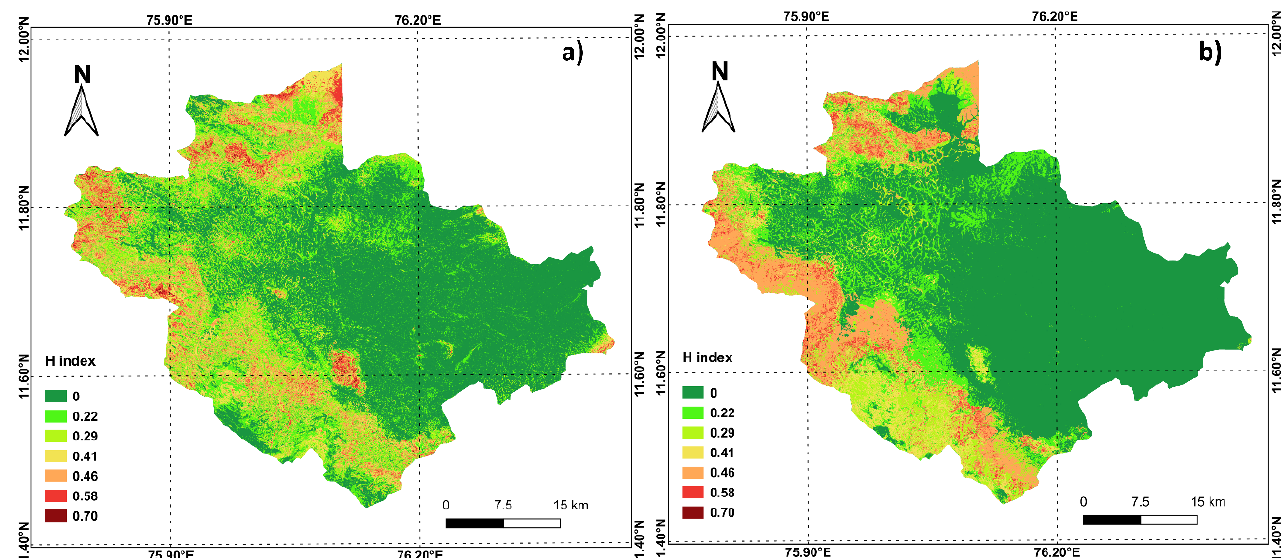
Figure 12. H-index maps plotted using all five algorithms with: ( a ) point data, and ( b ) polygon data. The percentage distribution of each value of H-index is provided in Table 3 below.